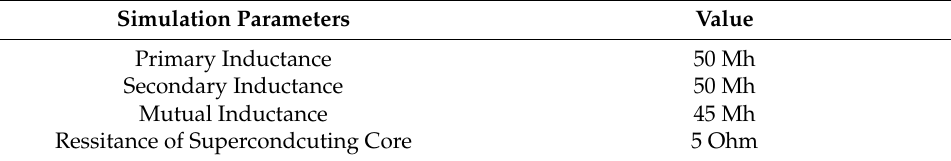
Table 6. Simulation